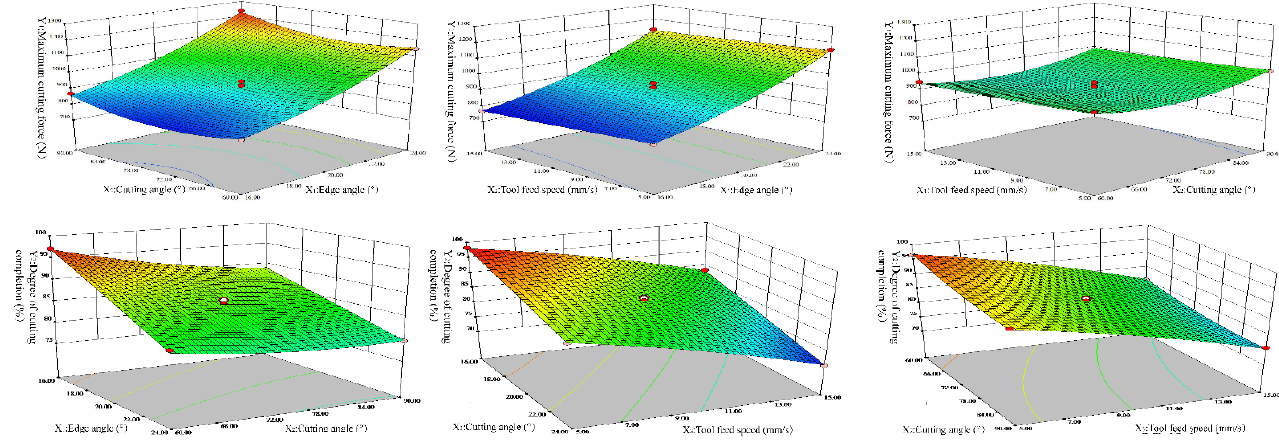
Figure 10. Orthogonal test response